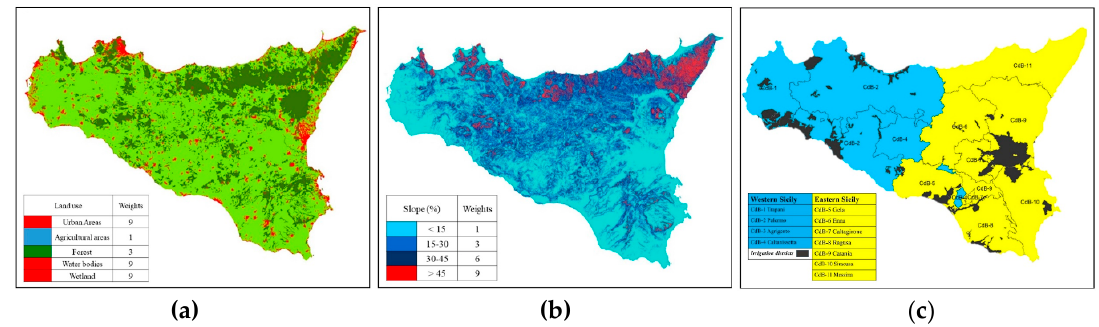
Figure 2. GIS-reclassified land use map ( a ), slope map of Sicily ( b ), and IC plus irrigation districts ( c ). Data were geo-referenced at the same projection (WGS84-UTM zone 33N) and integrated with GIS spatial overlay analysis functions. TW coming from WWTPs in operation were attributed to the